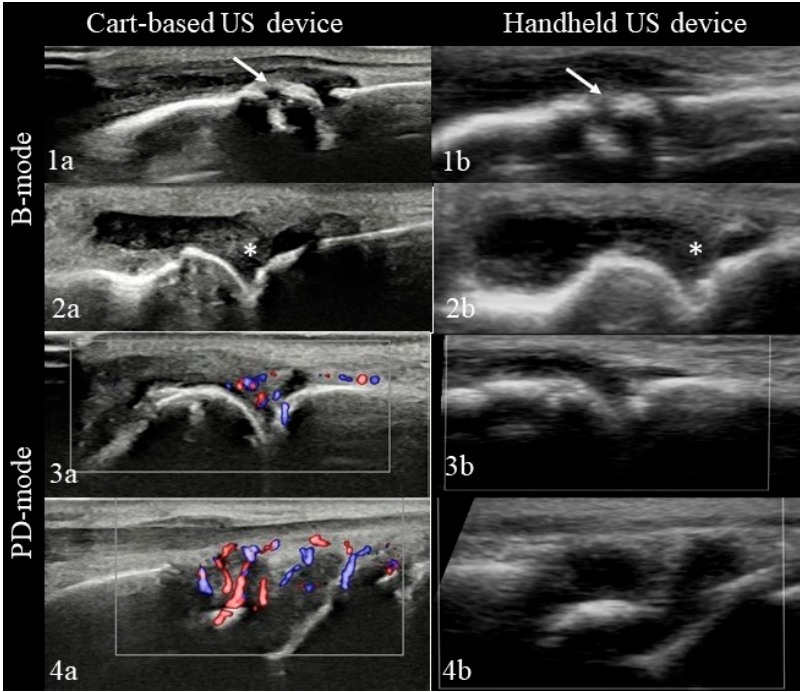
Figure 2. Pathological ultrasound findings depicted by the conventional and the HHUS ultrasound device. Images by the cart-based US machine are presented in the left column, images of the HHUS machine in the right column. B-mode changes of erosions (arrow) ( 1a , 1b ) and synovitis (asterisk) ( 2a , 2b ) in a metacarpophalangeal (MCP) joint displayed by both devices. PD changes of a MCP ( 3a , 3b ) and wrist joint ( 4a , 4b ) could only be visualized by the conventional US device. Table 2. Concordance between portable US device and conventional US device in B mode.